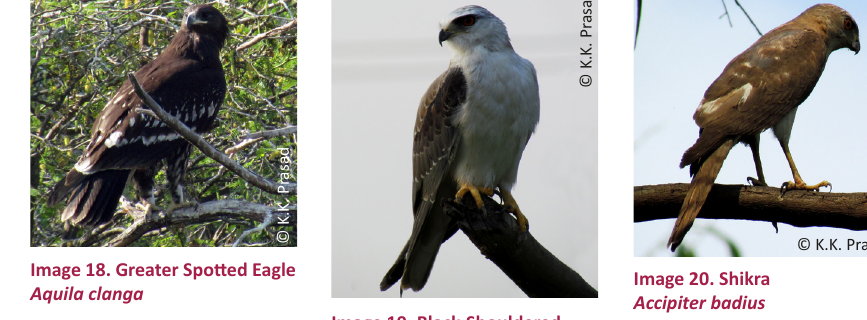
Image 19. Black-Shouldered Kite Elanus caeruleus